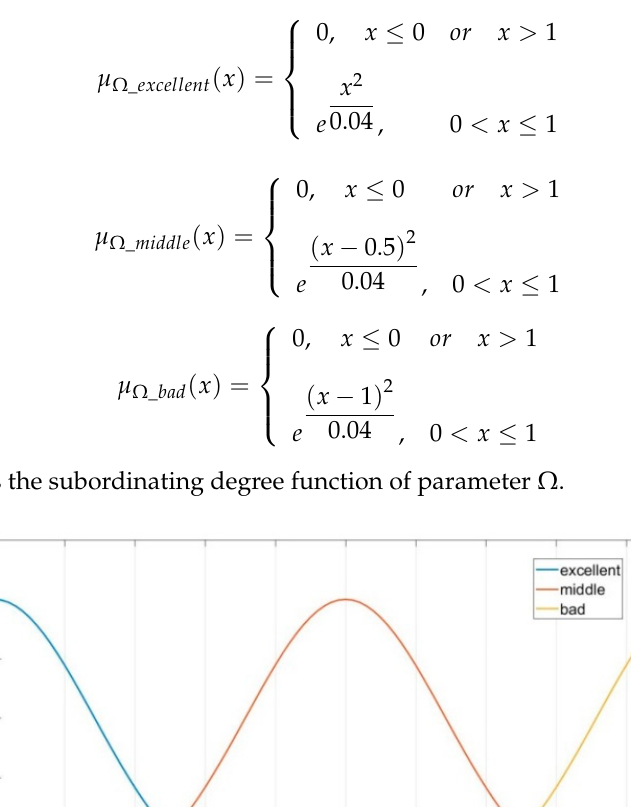
Figure 4. Subordinating degree function of parameter η .